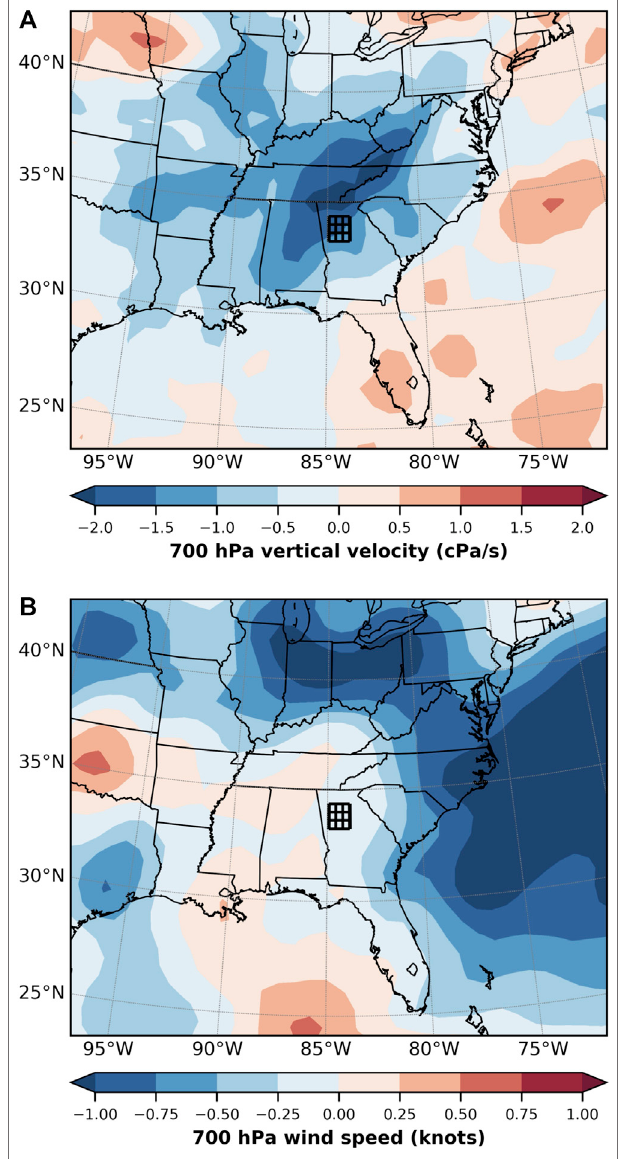
FIGURE5| Compositeanomalymapof (A) 700 hPaverticalvelocityand (B) 700 hPawindspeedforURDscomparedtonon-URDs.The9-cellgridded framework centered on Atlanta is indicated by the black-outlined boxes.